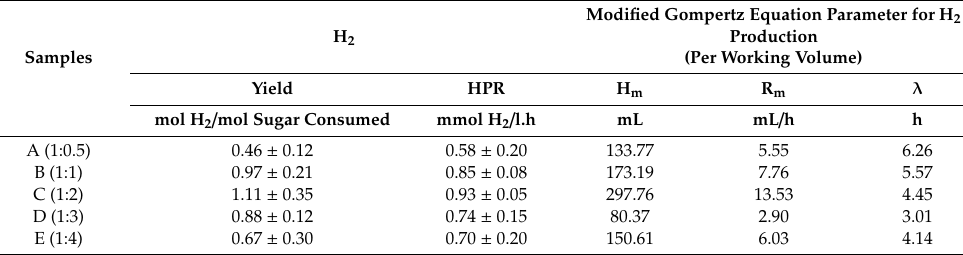
Figure 6. Hydrogen productivity rate (mmol H 2 / l.h) and hydrogen yield (mol H 2 / mol sugar) in the different concentrations of chitosan. Table4. Hydrogenproductivityobtainedfromdi ff erentconcentrationsofchitosaninbatchfermentation.